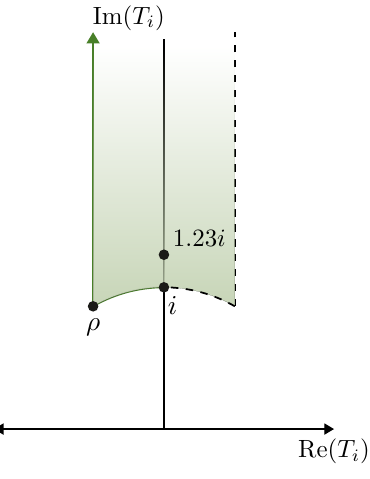
1 . 23 i found in heterotic i '